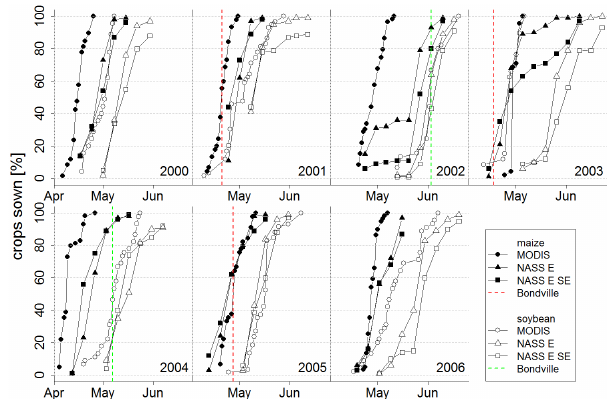
Fig. 4. Crop sowing progress for the study area and the two surrounding NASS census districts (East and East-South East) for the seven study years (2000–2006). MODIS-derived model estimates (circles) and NASS reported values (triangles and squares) are shown as percentage of crops sown within the respective regions. Reported sowing dates for the Bondville EC flux site are indicated by dashed vertical lines (red: maize, green: soybean).